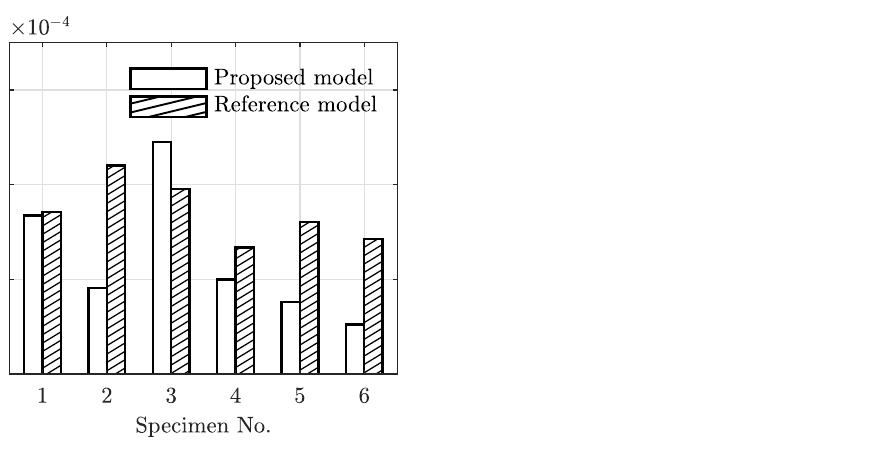
Figure 16. Comparisons of the performance in terms of RMSE between the proposed model and the reference